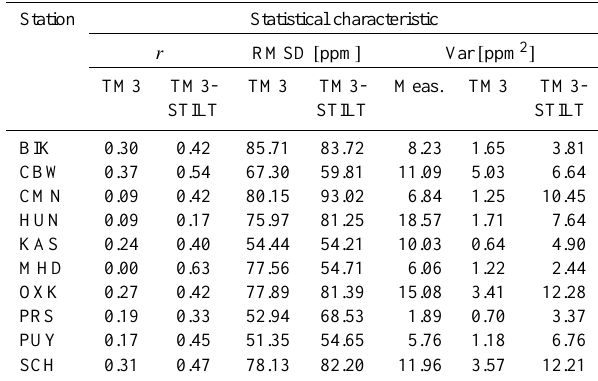
Table 2. Statistical characteristics of modelled time series (global mean and seasonal cycle subtracted): r - correlation coefficient, RMSD - Root Mean Square Deviation between observed and mod- elled time series, and Var - variance of the measured and modelled tile series.